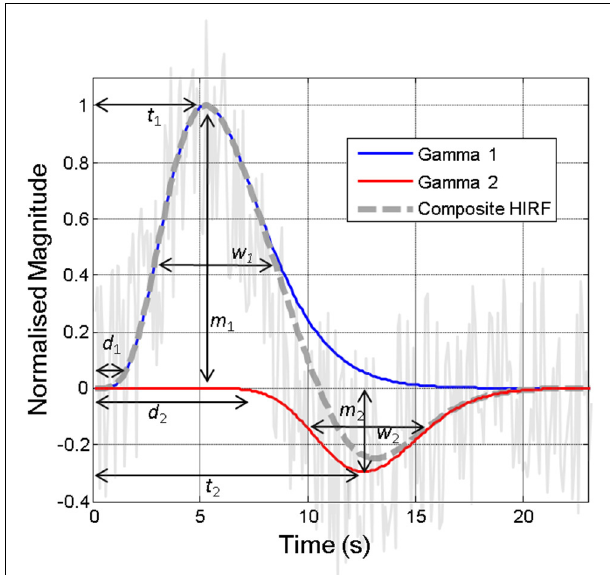
FIGURE 2 | Illustration of the hemodynamic impulse response function (HIRF, dashed gray line), which typically comprises two gamma functions (red and blue lines), together approximating the hemodynamic responses present in often noisy acquired neuroimaging data (solid gray line). The various parameters required to specify the HIRF are illustrated. Variations in these parameters that are not accounted for can lead to inaccurate detection of “activity” in neuroimaging studies. Some of the factors that might alter these parameters are illustrated in Figure 6